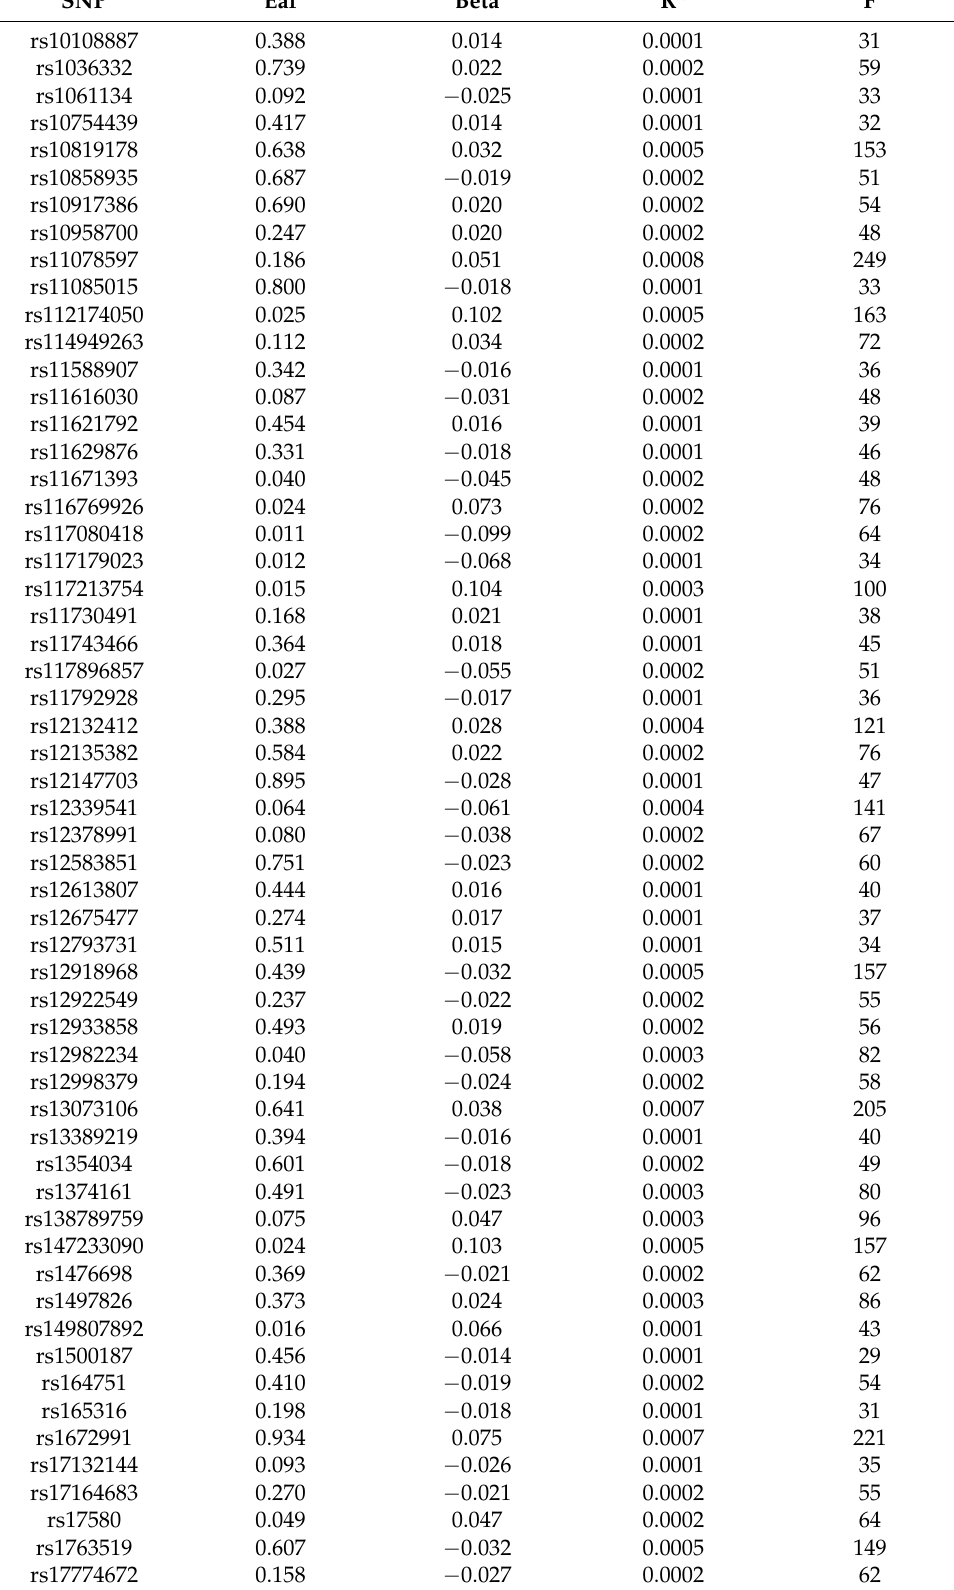
Table A2. The F statistics for SNPs strongly associated with